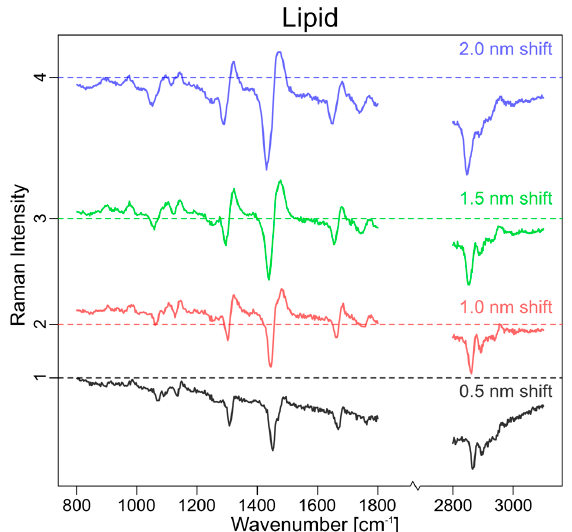
Figure 4. Measured difference mean raw spectra of a lipid cluster at different excitation wavelength shifts (shift: 0.5 nm (black), 1.0 nm (red), 1.5 nm (green), 2.0 nm (blue)). shifts (shift: 0.5 nm (black), 1.0 nm (red), 1.5 nm (green), 2.0 nm For the comparison of SERDS and EMSC, the largest possible shift was applied for the experimental measurements. Raw spectra ( λ 1 = 786 nm, λ 2 = 784 nm, λ SERDS = λ 1 − λ 2 ) were used to generate the SERDS spectra. The EMSC correction was performed on the spectra measured at 785.0 nm.